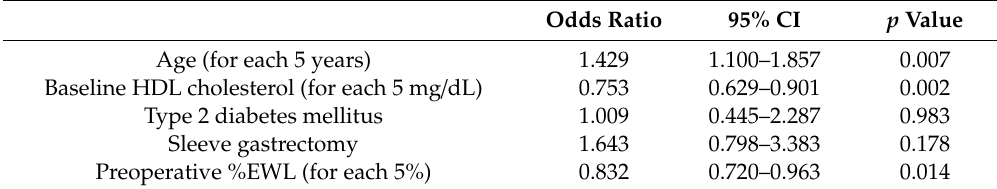
Table 4. Multivariate analysis of factors associated with poor mid-term WL after bariatric